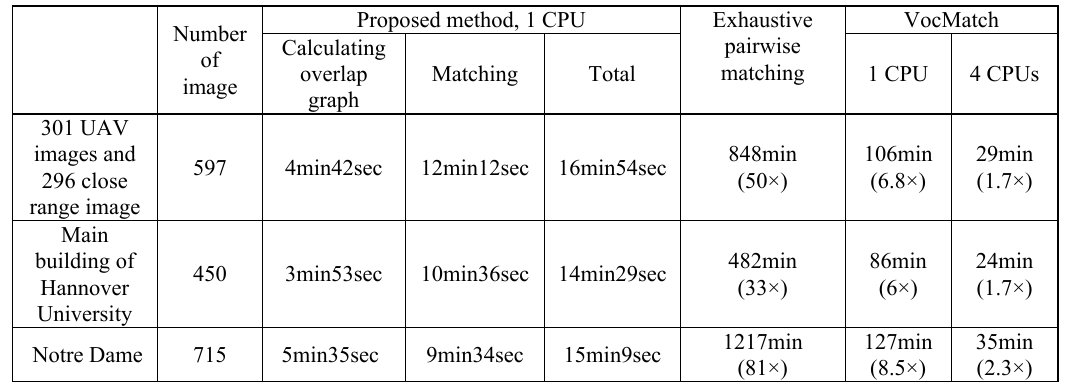
Table 1. Computational time needed for three methods for processing the three data sets. In our method, matching refers to the